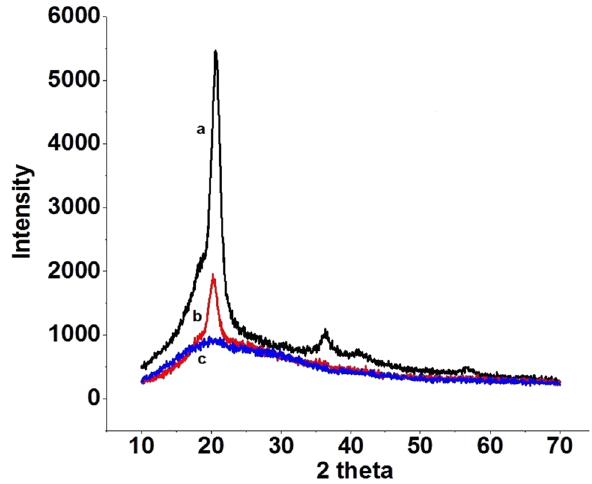
Fig. 3 XRD patterns of a PVdF, b PVdF–PMMA (80:20), and c PVdF–PMMA (50:50) nanofibrous